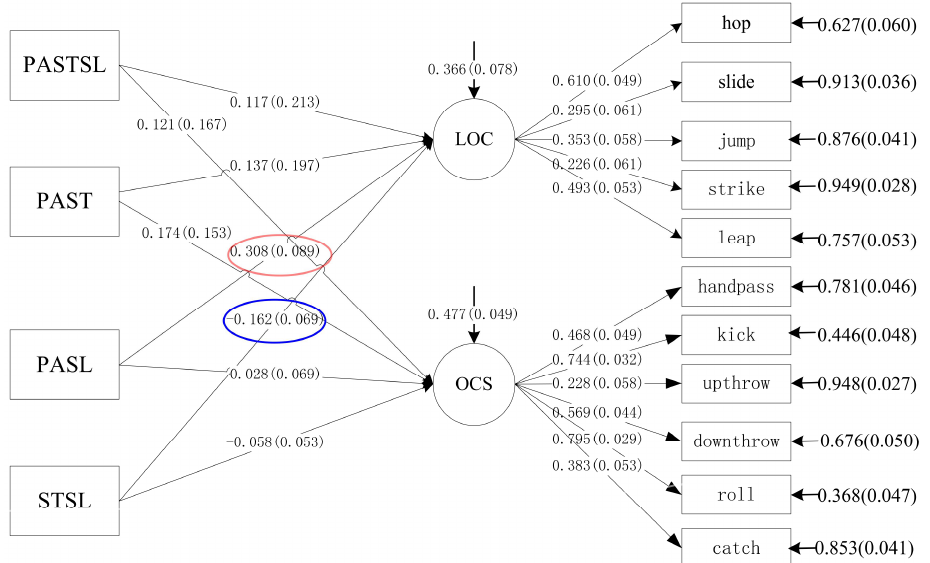
Figure 2. Structural model of the association of the combinations of 24-Hour Movement Behavior Guidelines that were met and fundamental movement skills in preschoolers. (PASTSL = physical activity + screen time + sleep; PAST = physical activity + screen time; PASL = physical activity + sleep time; STSL = screen time + sleep time; LOC = locomotor skills; OCS = object control skills). Colored with red line indicates significant positive relationship; Colored with blue line indicates significant negative relationship.